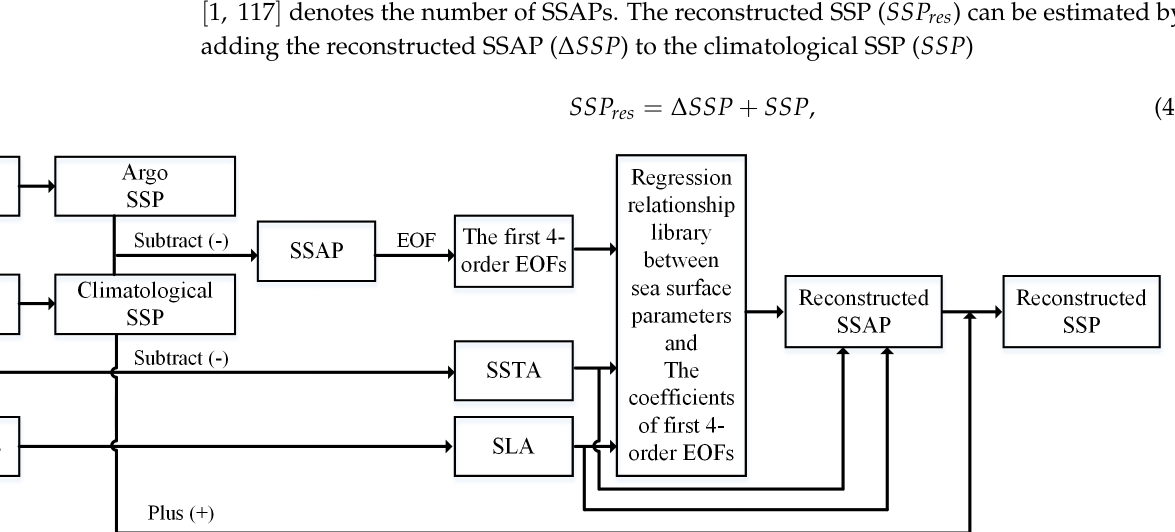
Figure 1. Diagrammatic sketch of a 2° × 2° grid. The hollow red circle represents the climatological SSP derived from T/S in WOA18, and the black dot represents the Argo SSP derived from T/S in BOA_Argo 2018 dataset.